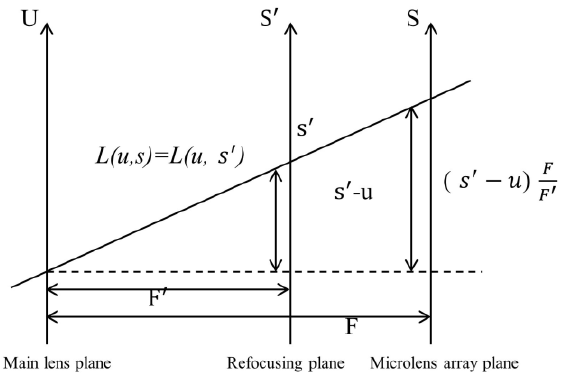
Figure 1. Refocusing principle schematic.